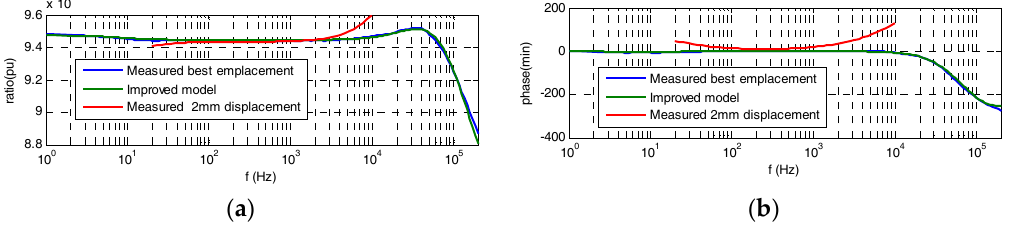
Figure 10. Frequency response curves measured with the best emplacement of the 2nd HV resistance (blue curve), with a vertical displacement of 2 mm (red curve), and obtained by PSPICE simulating the frequency response of best emplacement of the 2nd HV resistance (green curve) using the coefficient k = 0.96 to the frequency response measured: ( a ) ratio error; ( b ) phase displacement error.